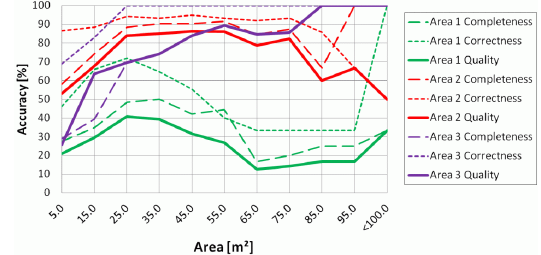
Figure 7: Evaluation of trees on a per-object level as a function of the object area